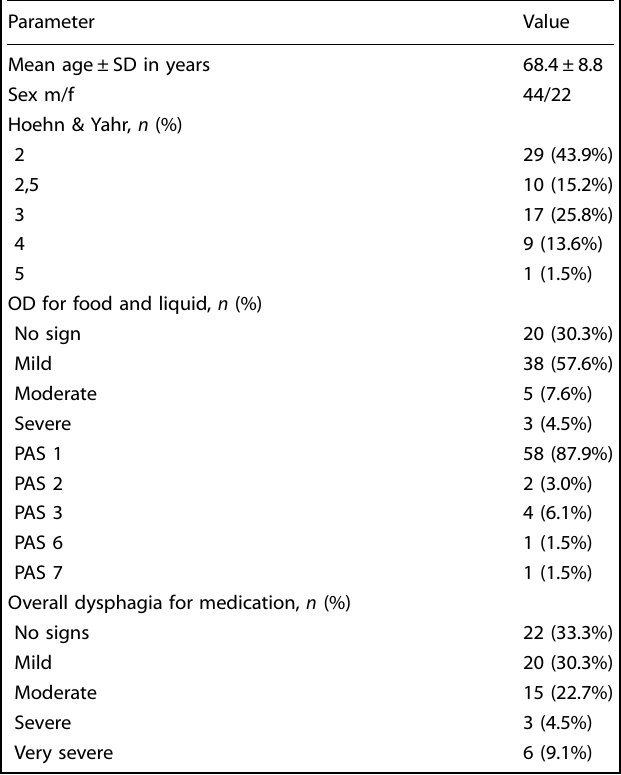
Table 1. Demographics and prevalence of oropharyngeal dysphagia for food and liquid and dysphagia for medication: SD standard deviation, OD oropharyngeal dysphagia, PAS Penetration Aspiration